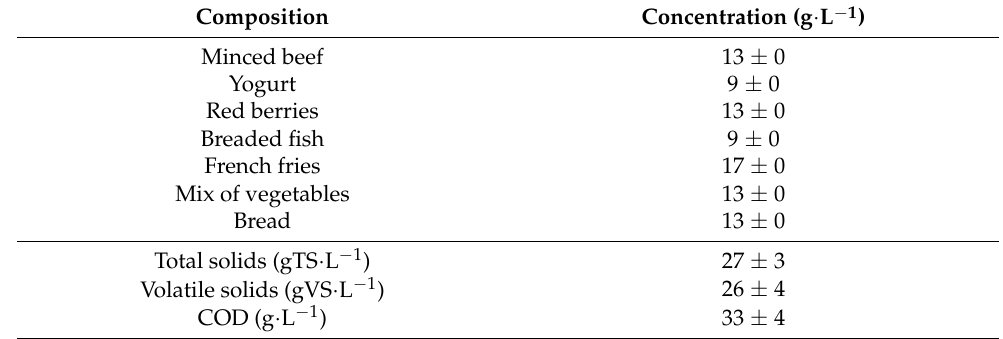
Table 1. Feedstock